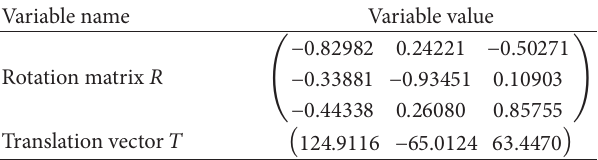
Table 1: Rotation matrix 𝑅 and translation vector 𝑇